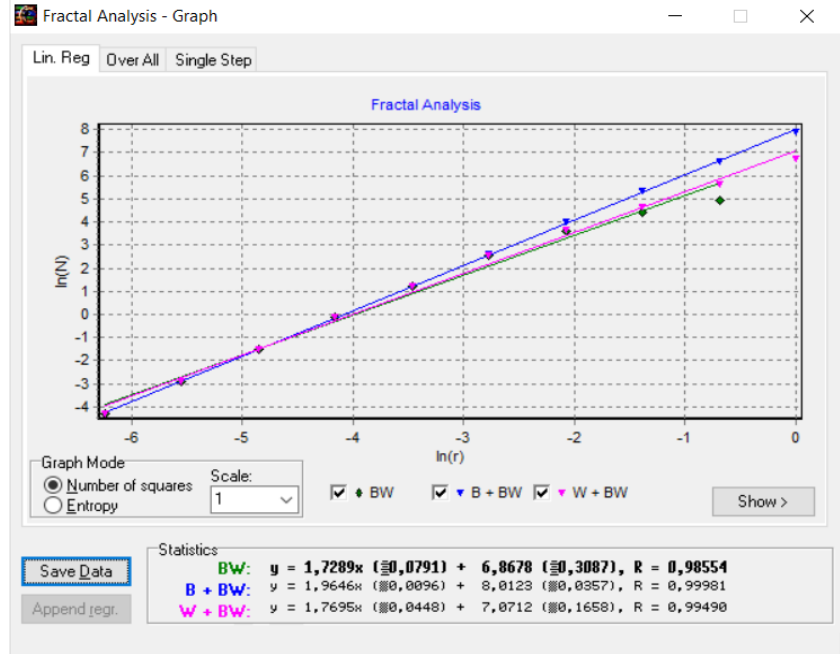
Figure 11. Graphic of the fractal dimension for the affected/modified area.